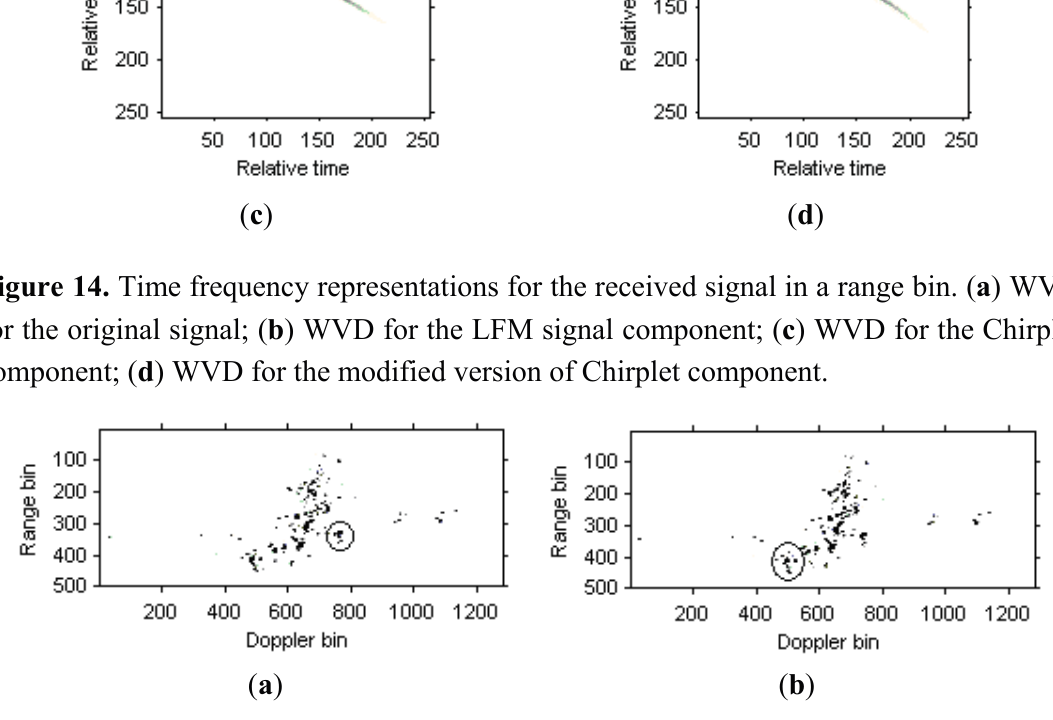
Figure 15. Radar images based on LFM signal model. ( a ) Radar image at time t = 1.01 s; ( b ) Radar image at time t = 1.23 s.